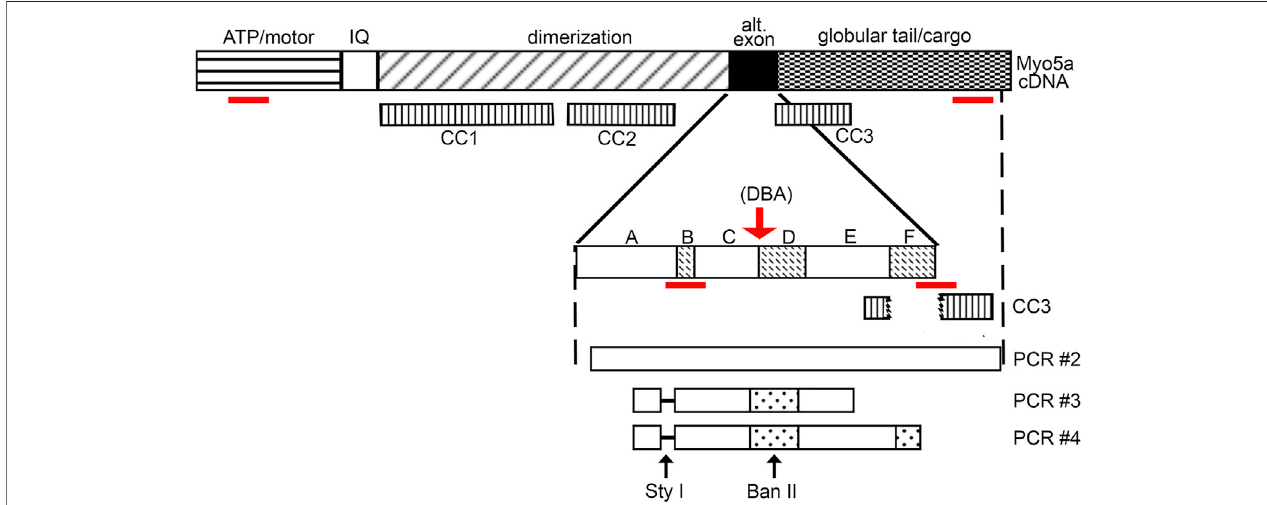
FIGURE 2 | Myo5a schematic. Schematic of Myo5a mRNA/cDNA, depicting regions encoding the major structural domains of the Myo5a protein monomer: the ATPhydrolyzing/actin bindingmotor domain, thelight-chain bindingIQdomain, thecentraldimerizationdomain, thealternative exondomain, and theglobular tail/cargo binding domain. Three coiled-coil regions (CC1, CC2, and CC3) have been described and are shown in the second line; CC1 and CC2 are within the dimerization domain, while CC3 is intact only in variants that do not contain exon F (such as the predominant brain form of Myo5a, ABCE), since it includes part of exon E sequence and part of globular tail domain sequence. CC3 is bisected by exon F, if present. Alternative exons are shown in the expansion; sequence encoding the constitutive exons A, C and E and the optional exons B, D and F are indicated by solid and speckled patterns, respectively. The red arrow indicates the position of the molecular defect in the Myo5a gene in the DBA mouse, which impairs mRNA splicing. Below, the products of detrusor nested PCR reactions are shown, as are the locationsofrestrictionenzymecleavagesites.TheabsenceofexonB(anditsdiagnosticStyIrestrictionsite)indetrusornestedPCRproductsisindicatedbythedashed line. The red lines indicate the positions of the RT-PCR assays